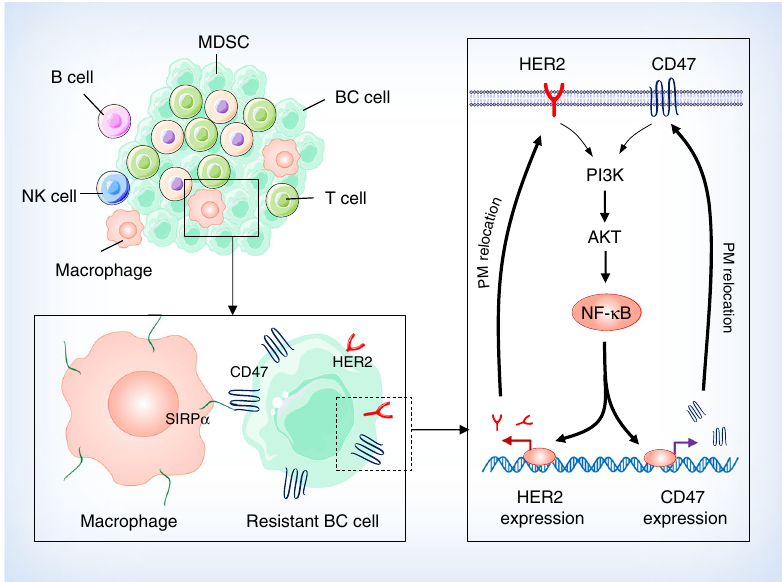
Fig. 7 A cellular model of radioresistant breast cancer is proposed in which two cell surface receptors CD47 and HER2 coordinately contribute to the aggressive phenotype of breast cancer cells surviving radiotherapy. The radioresistant breast cancer cells that are enriched with breast cancer stem cells can not only survive radiation but also enhance their immune-escaping ability via CD47-mediated anti-phagocytosis. CD47 transcription is regulated via HER2 – NF- κ B axis leading to the enhancement of both receptors on the cell surface. Thus, HER2-promoted intrinsic proliferation is synergized with the CD47-initiated extrinsic anti-phagocytosis; a dual blockade of these two receptors may eliminate the radioresistant breast cancer cells in breast cancer